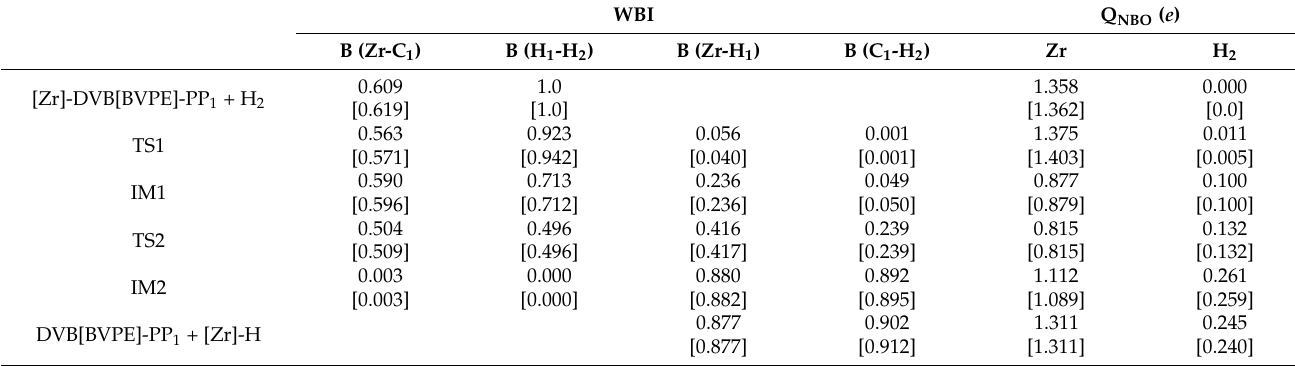
Table 1. The Wiberg bond indices (WBI) and natural charges (Q NBO ) for some key bonds and atoms of the reaction pathway involving hydrogen; the values of BVPE are given in brackets. WBI Q NBO ( e